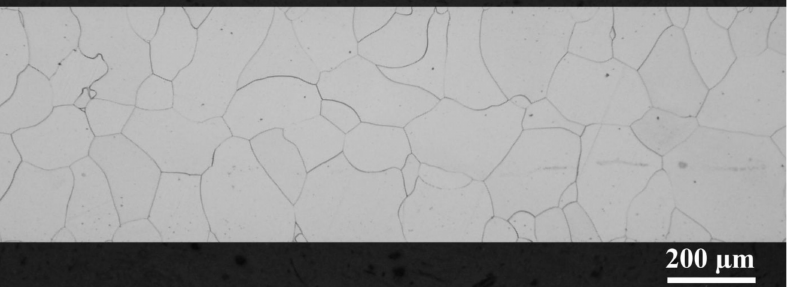
Figure 2. Initial (as-received) microstructure of investigated ‘fully finished’ non-oriented electrical steels before punching and annealing.